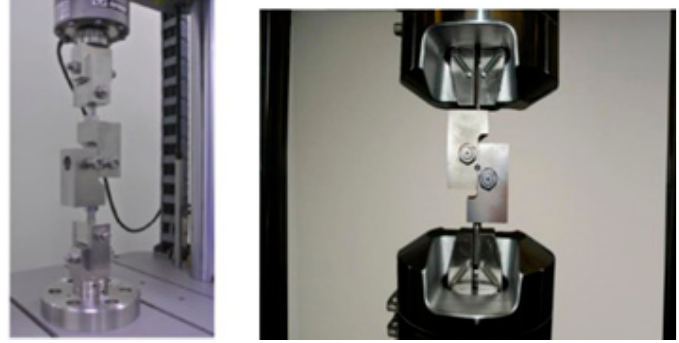
Figure 6. Tensile shear fatigue test